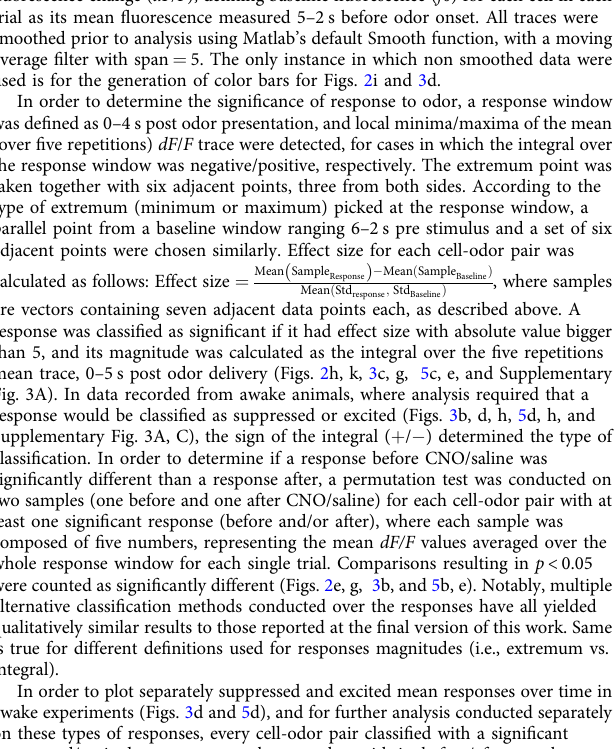
Fig. 5 The impact of abGCs on MCs odor coding gradually decreases with age. a The timeline of the experiment. b Left: 2P micrographs of MCs before and after CNO administration, 8, 12, and 16 WPI. Right: calcium transients before (blue) and after (red) CNO injection, from three neurons (marked on the adjacent micrographs). All details are as in Fig. 3b. c Cumulative distribution of the proportion of MCs responding to 0 – 11 odors, across conditions (8 WPI: n = 113 cells, p << 0.0001; 12 WPI: n = 101 cells, p < 0.05, 16 WPI: n = 104 cells, p = 0.96, Kolmogorov – Smirnov tests, two-tailed for 8 WPI, one-tailed for 12, 16 WPI). d Traces of the average ± SEM calcium responses to odor stimulation before and after CNO at the three age groups. e All responding cell-odor pairs before and after CNO at the three age groups. Red dots are signi fi cantly away from the diagonal. The proportions of cell-odor pairs showing signi fi cant difference before vs. after were signi fi cantly different between the different sessions ( n = 1666 cell-odor pairs in total, p << 0.0001, Chi squared test for equality of proportions). f Quantitative analysis of the difference in MCs responsiveness along age ( F 2,182 = 17.96, p << 0.0001, one-way ANOVA for repeated measures; 8 WPI vs. 12 WPI: n = 101 MCs, p < .01; 8 WPI vs. 16 WPI: n = 103 MCs, p << 0.0001; 12 WPI vs. 16 WPI: n = 92 MCs, p <